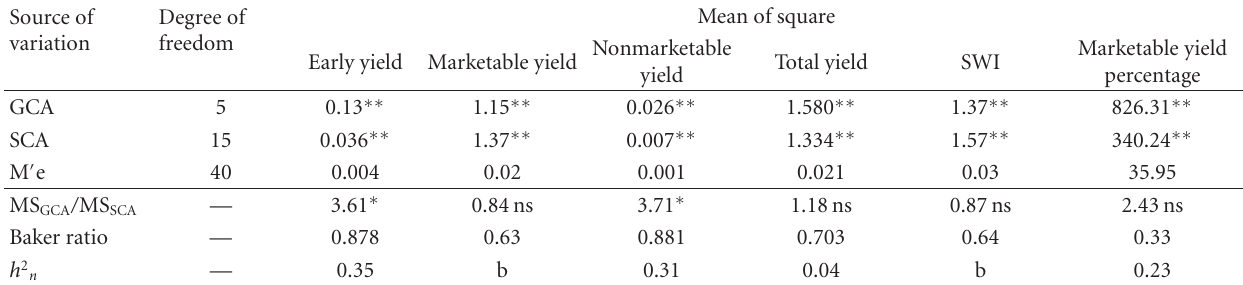
Table 3: Mean squares from diallel analysis for various characters in cucumber (Gri ffi ng’s model I Method 2). Source of variation